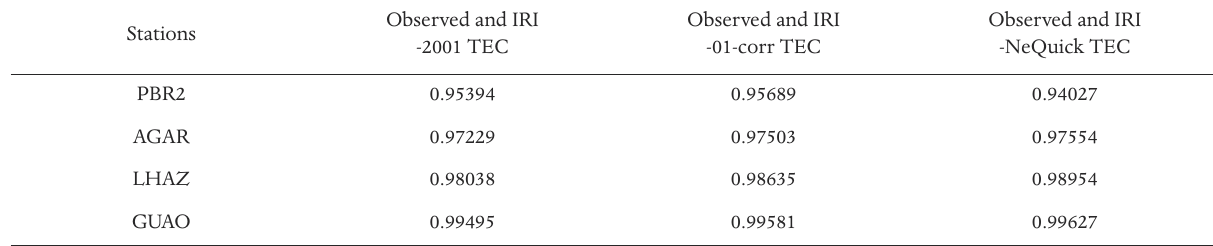
Table 1. List of correlation coefficient between the annual mean of observed and